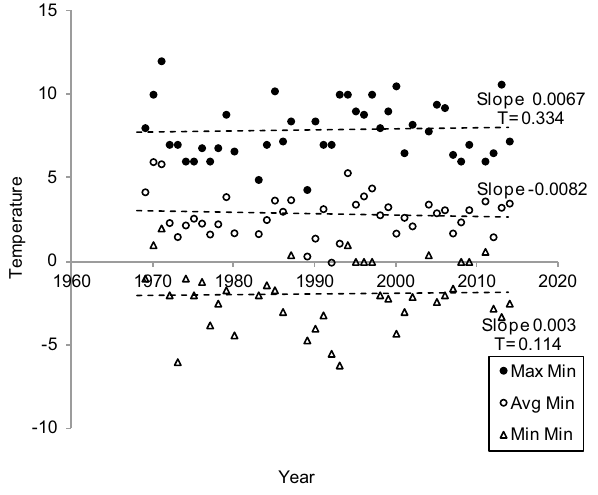
Fig. 4 Monthly minimum temperature in January Al Safawi